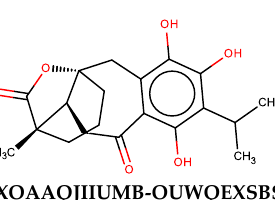
Figure 5. The structures of natural compounds along with the InChIKey codes found in the BIOFACQUIM database, which were classified as active beta-glucosidase inhibitors by all SANNs employing maxHBint3 and SpMax8_Bhs